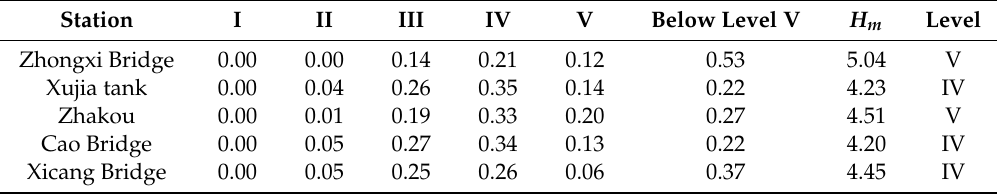
Table 2. Closeness degree and river water quality level in 2010 for five stations along the Caoqiao River. Station I II III IV V Below Level V H m Level Zhongxi Bridge 0.00 0.00